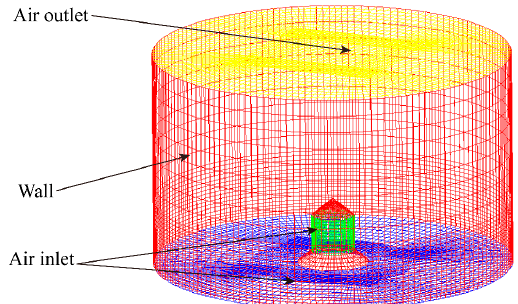
Figure 2. Boundary condition settings and element generation of the simulation domain.